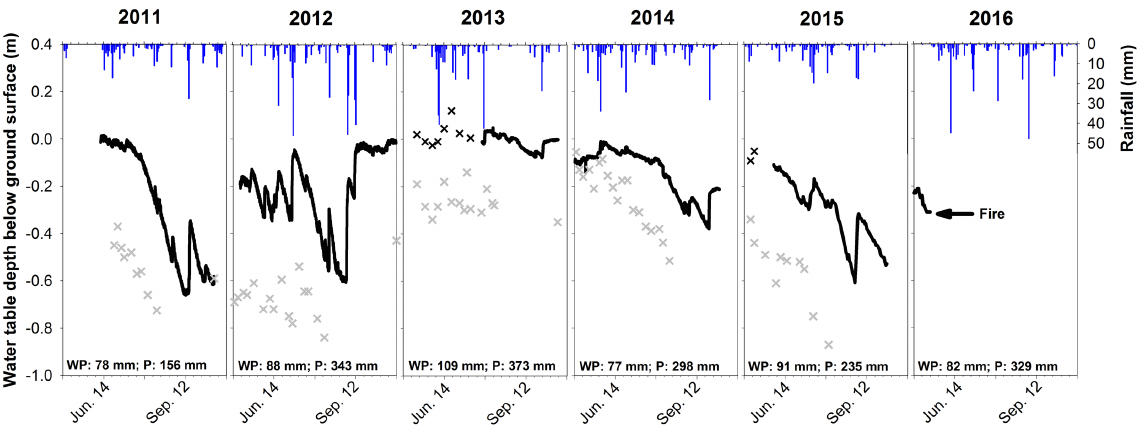
Figure 5. Logged (lines) and manually (“x” symbols) recorded water table position at NW fen (black) and NW margin (grey) (see Fig. 1), from 2011 to 2016, with field-measured rainfall (P), and total winter precipitation (WP) interpolated for the Poplar Fen area. Table 3. The 19 April 2016 startup and final 17 May DCs for Poplar Fen using four different scenarios. Scenario number